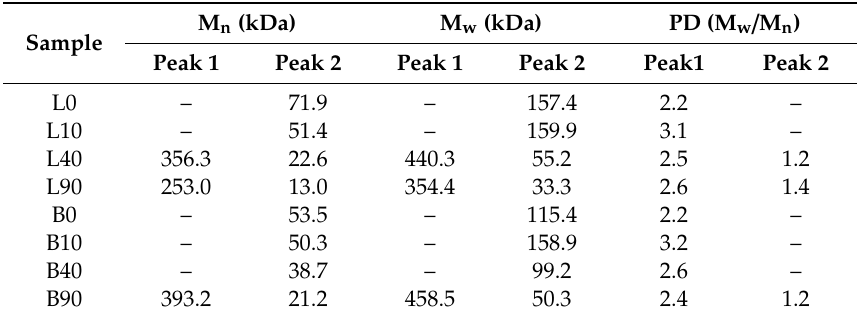
Table 2. Number-average molecular weight (M n ), weight-average molecular weight (M w ), and polydispersion degree (PD) of the samples type L and